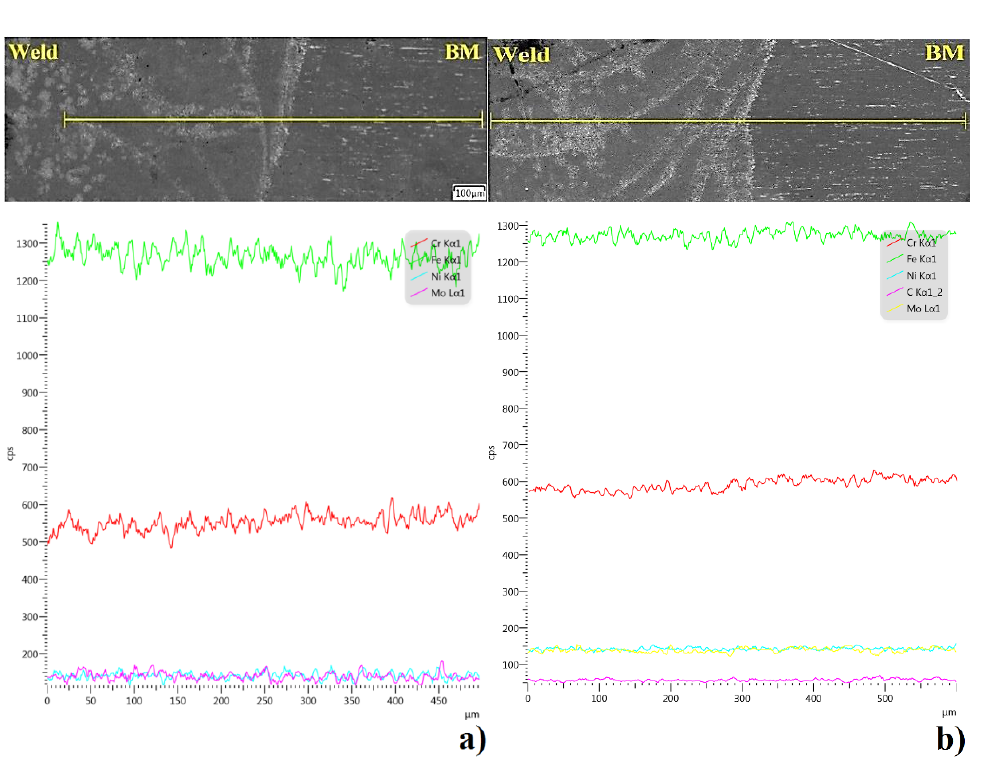
zone: ( a ) a weld made in air; ( b ) a weld made in an argon